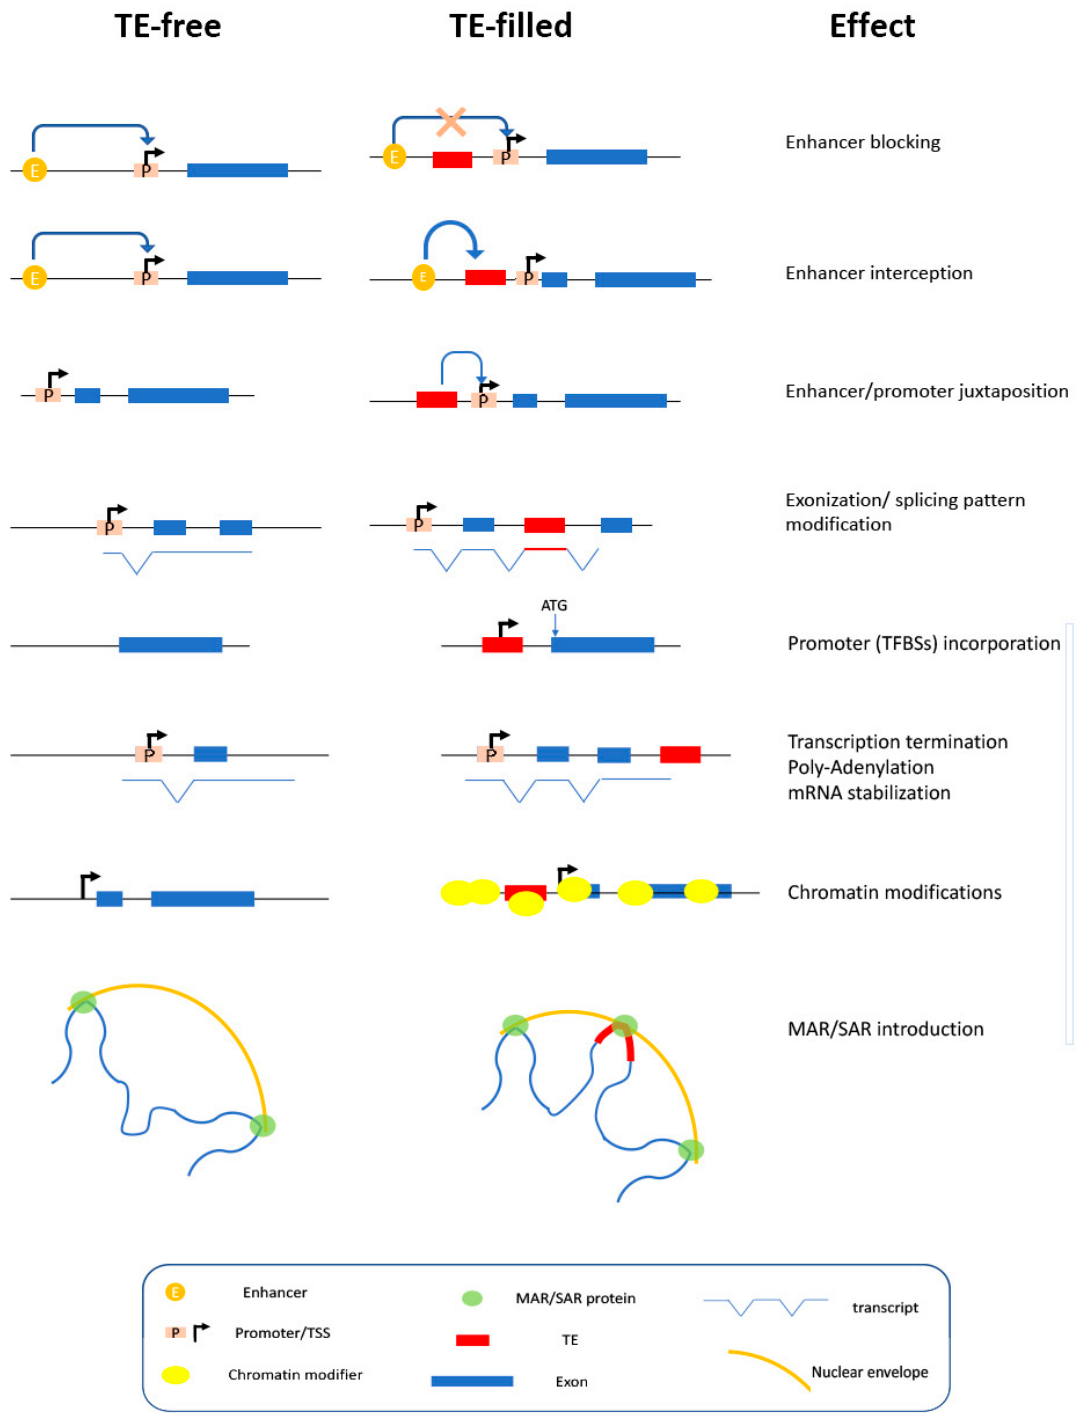
Figure 2. Schematic representation of the key effects produced by the cis -operating sequences upon TE insertion. Symbols are explained in the box.